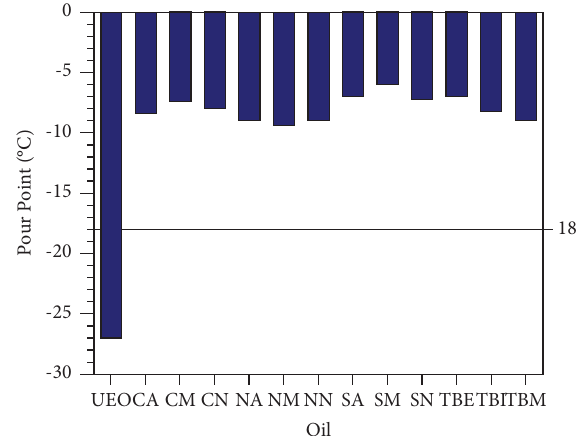
Figure 3: Pour points of used engine oil and refned oils compared to the pour point of SAE 30 oil